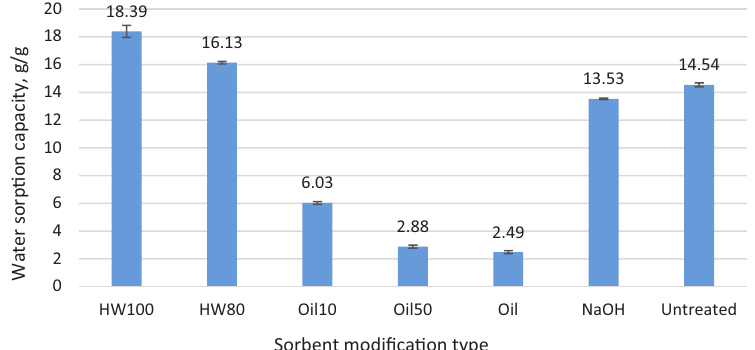
Figure 4. Sorbent water sorption capacity